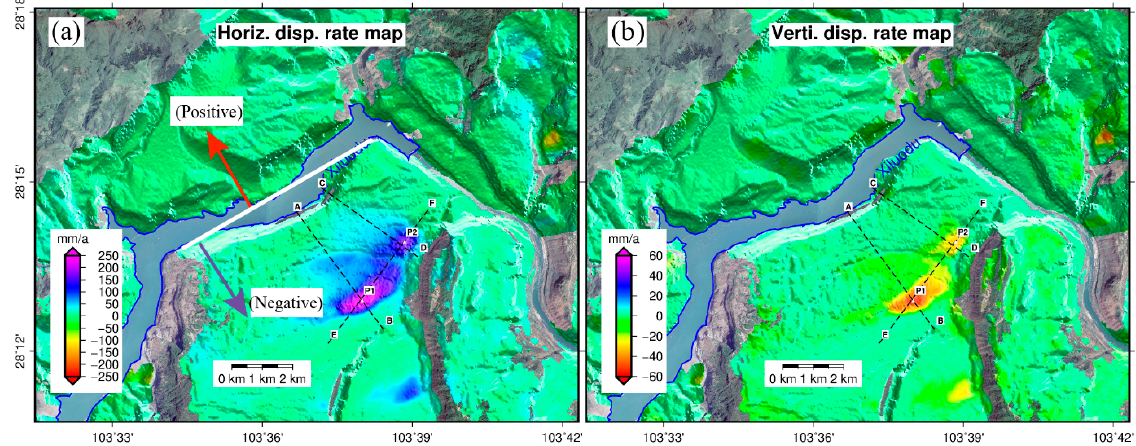
Figure 10. ( a ) Mean rate perpendicular to the shore direction; ( b ) vertical mean rate.